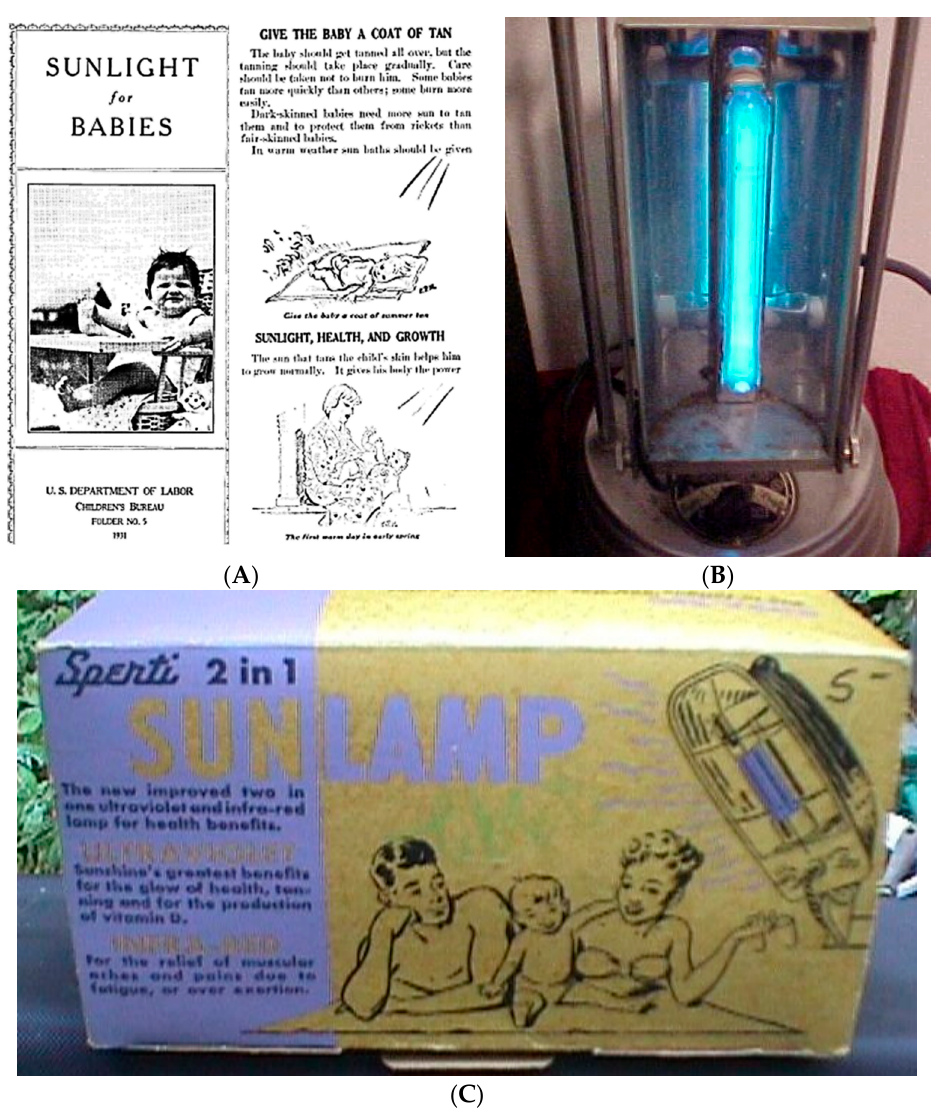
Figure 5. ( A ). Brochure from the US Department of Labor promoting sensible sun exposure for children in 1931. ( B ). Mercury arc lamp turned on for the use of preventing rickets in children in the 1930s. ( C ). The Sperti lamp available in the 1940s was used to expose children to ultraviolet radiation to promote bone health and to prevent rickets. Holick copyright 2023. Reproduced with permission.